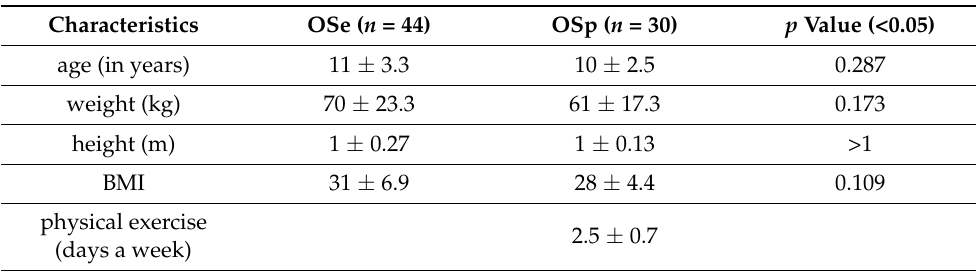
Table 2. Characteristics of the obese population. Anthropometric characteristics of children are expressed as mean ±